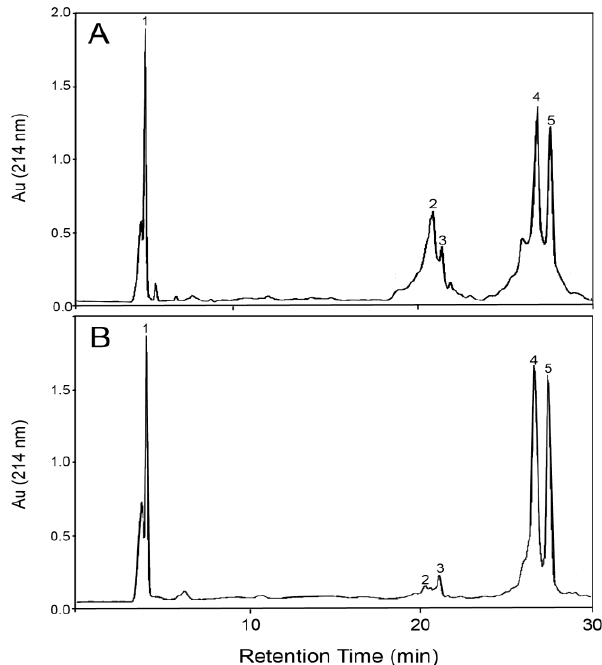
Table 1 lists the compositional analysis of a selection of soluble beta fractions as a function of SCO processing parameters ( C , T , calculated pH and t ), compared with the starting (untreated) 2 WPI WPI, as measured with HPLC and compared with the SDS-PAGE data. Some samples produced during a prior study [5] (rows 1, 3, 9 and 10) were reanalyzed and recalculated to obtain precise GMP contents and recovery